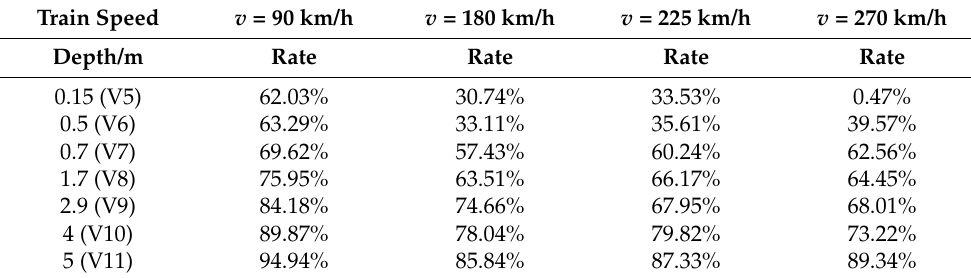
Table 8. Vibration attenuation rates of velocity along